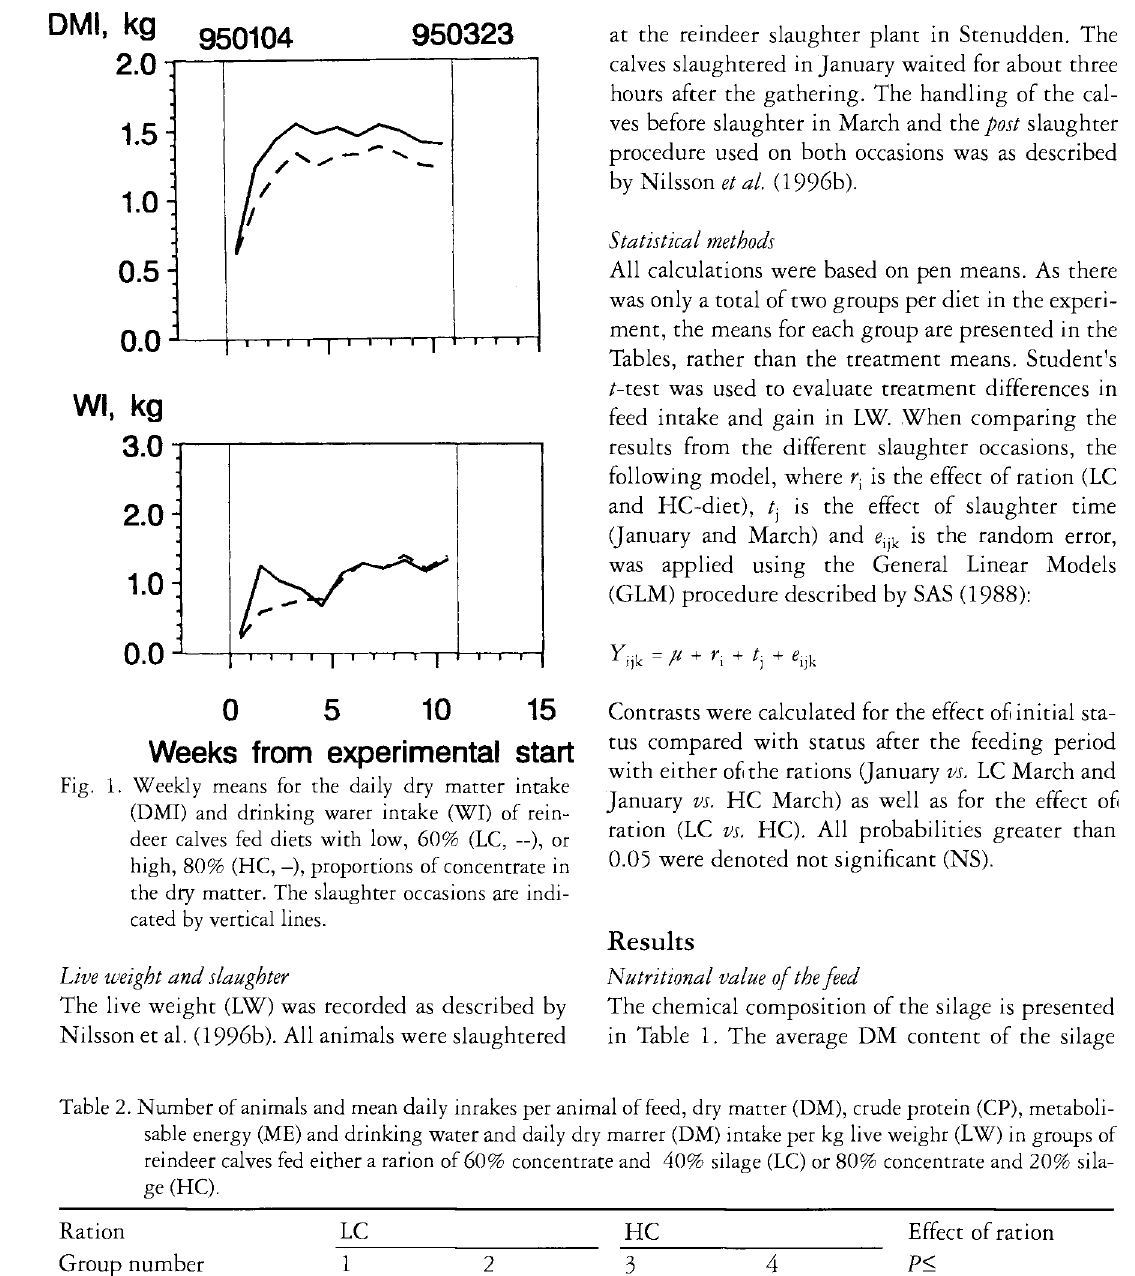
Fig. 1. Weekly means for the daily dry matter intake (DMI) and drinking warer intake (WI) of rein deer calves fed diets with low, 60% (LC, —), or high, 80% (HC, -), proportions of concentrate in the dry matter. The slaughter occasions are indi cated by vertical lines.